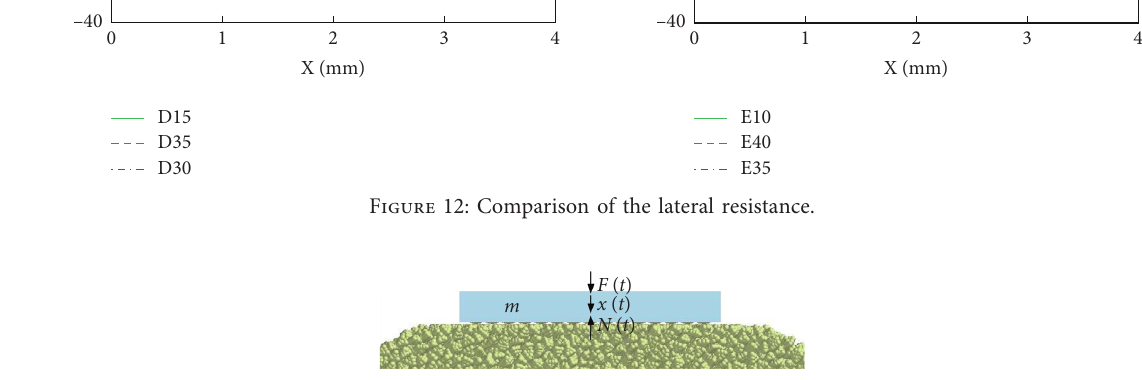
Figure 13: The analysis model of sleeper-track bed